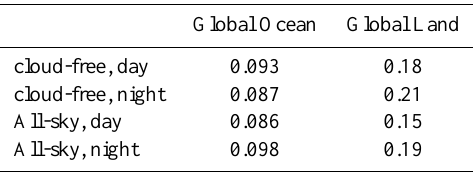
Table 1. Global mean 532nm AOD from monthly time series,